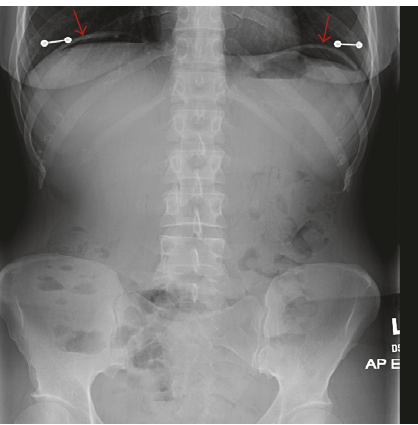
Figure 1: An anterior-posterior (AP) X-ray of the abdomen read as “free intraperitoneal air suggestive of a perforated viscus”